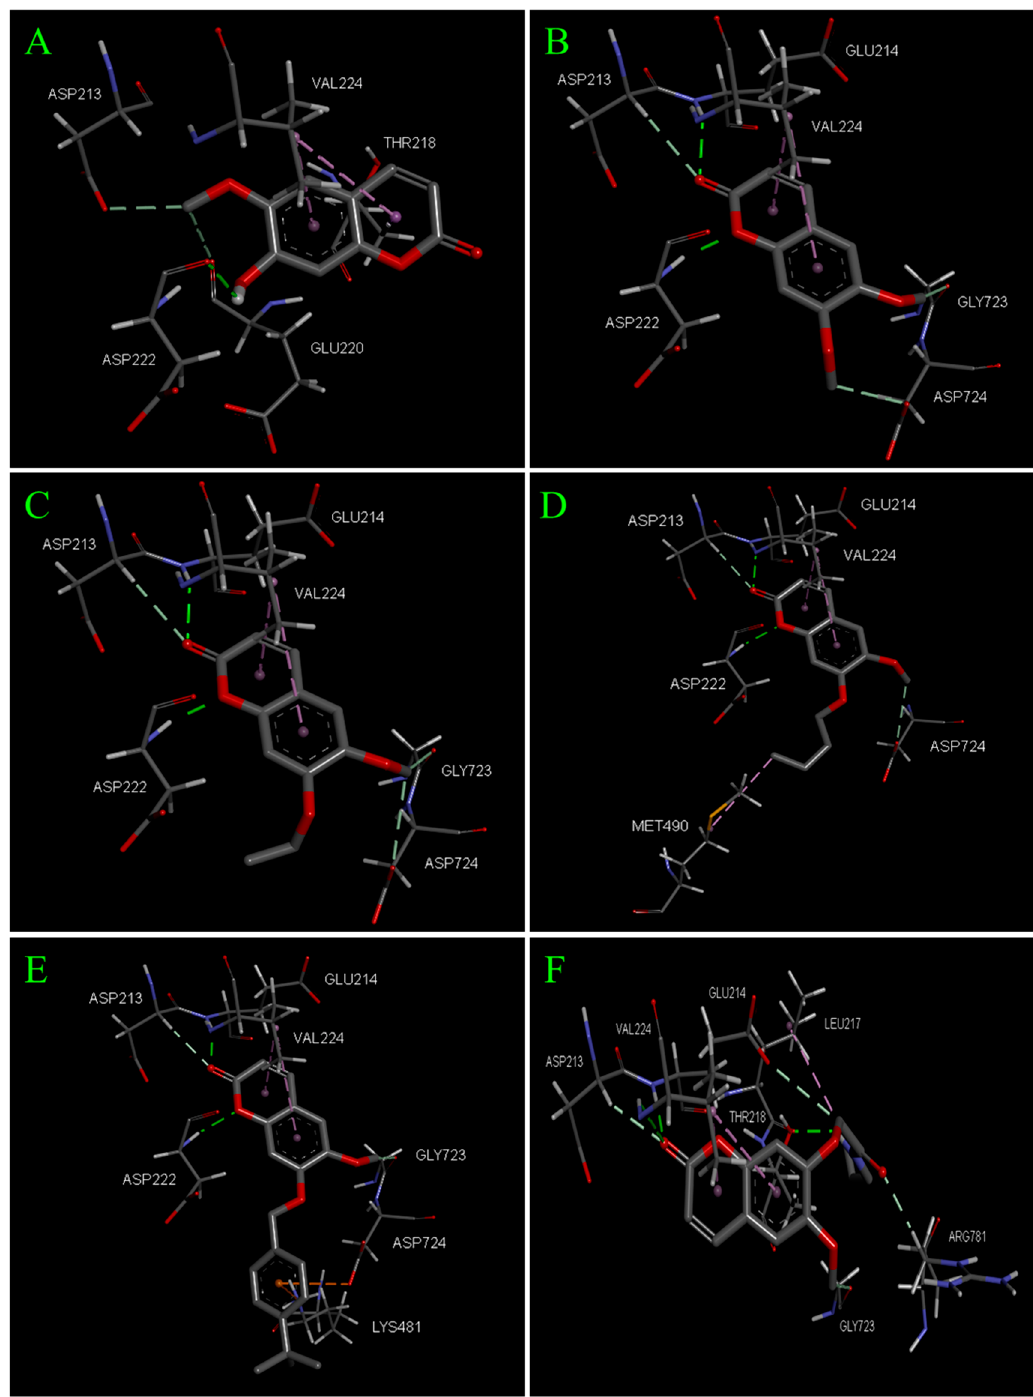
Figure 7. The recognized binding modes and molecular interactions of the scopoletin ( A ) and compounds 8 ( B ), 9 ( C ), 12 ( D ), 20 ( E ), 28 ( F ) in the active site of TcPMCA1 .